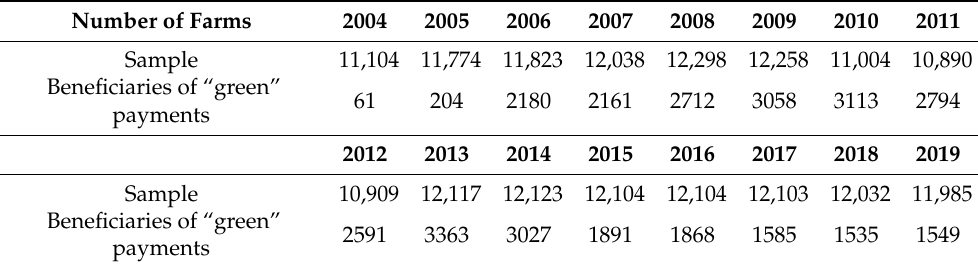
Table 1. Total number of farms and beneficiaries of “green” CAP payments in the research sample.